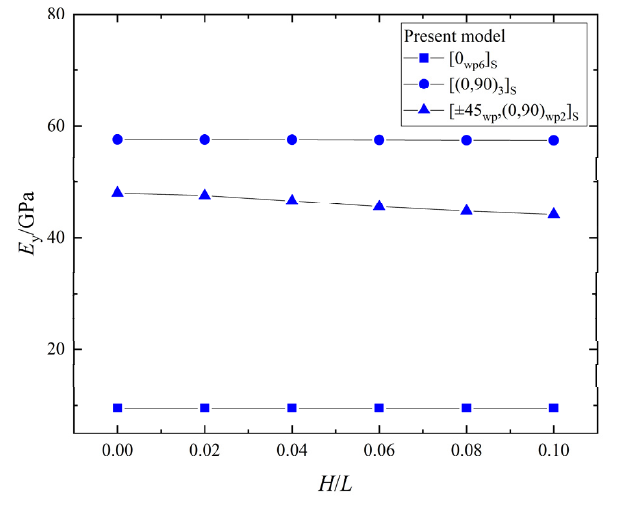
Figure 12. The effective elastic stiffness, 𝐸 y , vs. wrinkle parameter, 𝐻 / 𝐿 , in laminates. The relationship between the effective elastic stiffness, 𝐸 z eter, 𝐻/𝐿 , of the laminates with the three different ply stacking sequences is shown in Figure 13. The 𝐸 z of the [0 wp /90 wp ] 3 S and [ ± 45 wp ,(0,90) wp 2 ] S laminates decreases with the increase of 𝐻/𝐿 , and the maximum percentage decreases are 5.6% and 5.7%, respectively; while the 𝐸 z of the [0 wp 6 ] S laminate increases with the increase of 𝐻/𝐿 , and the maximum percentage in- crease is 2.5%. Therefore, the effect of the wrinkle defect parameter, 𝐻/𝐿 , on laminates is closely related to the ply stacking sequence, and the direction of the effect may be opposite with different ply stacking sequences.